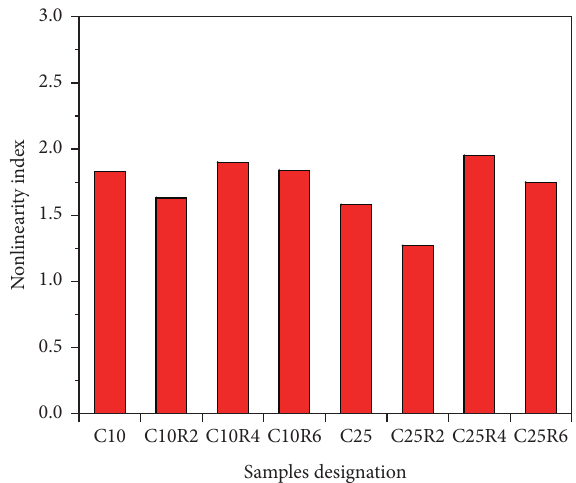
Figure 8: Nonlinearity index values of cemented tailings